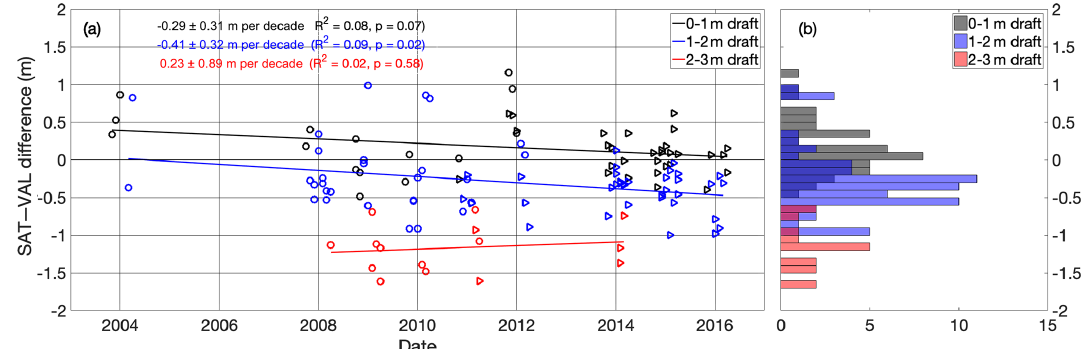
Figure 6. (a) Difference (SAT–VAL difference) between gridded monthly mean ENVISAT (CS2) and VAL ice drafts in circles (triangles) for thickness ranges from 0 to 1m (black), 1 to 2m (blue) and 2 to 3m (red). Linear trends were computed for each of the thickness ranges. (b) Distributions of 0 to 1m (black), 1 to 2m (blue) and 2 to 3m (red) thickness range SAT–VAL